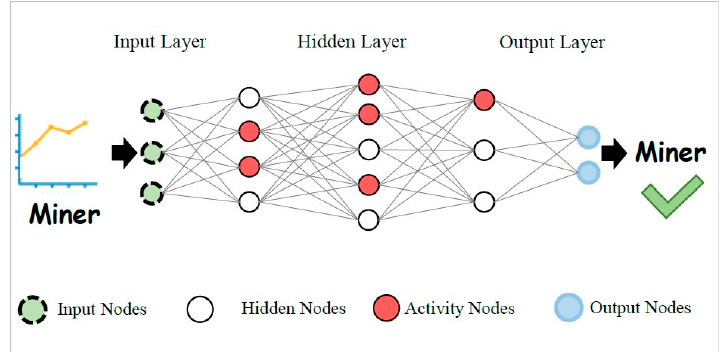
Figure 14. ANN model successful prediction.